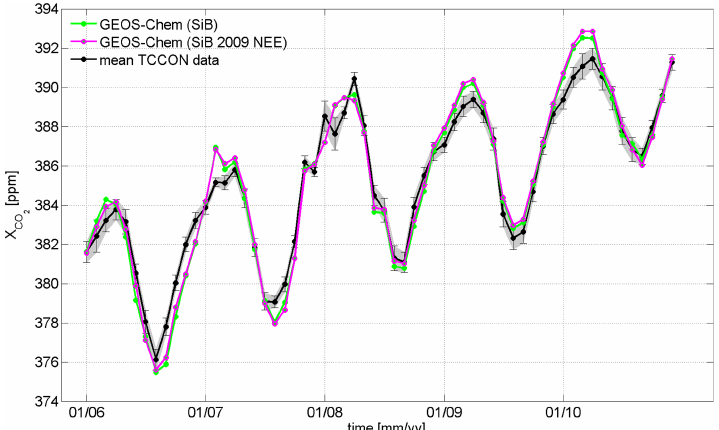
Fig. 5. The same as in Fig. 2, showing the monthly mean X CO for the GEOS-Chem CO 2 simulation using year-specific SiB fluxes and using 2 only SiB 2009 NEE estimations for the whole time period. The differences between these GEOS-Chem CO 2 simulations give a measure of the impact of year-specific SiB NEE fluxes in contrast to the climatology, showing only slight differences. The variability of the TCCON time series in the winter of 2007–2008 is due to the few measurements averaged (Table S1 in the Supplement).